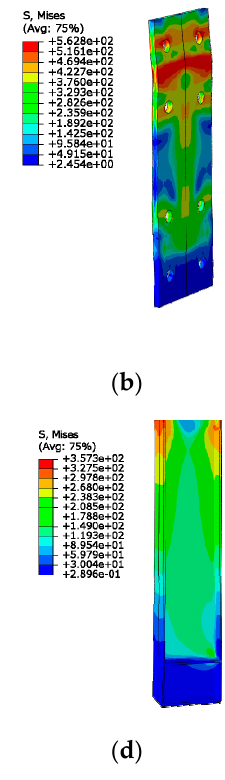
Figure 27. Predicted weakest component deformation. ( a ) Outward deformation of the column flange in specimen SJ-2; ( b ) Flexural deformation of the thick end-plate in specimen SJ-3; ( c ) Fractured bolt in specimen SJ-4 (bending and shearing fracture); ( d ) Local buckling of the steel beam in specimen SJ-6.